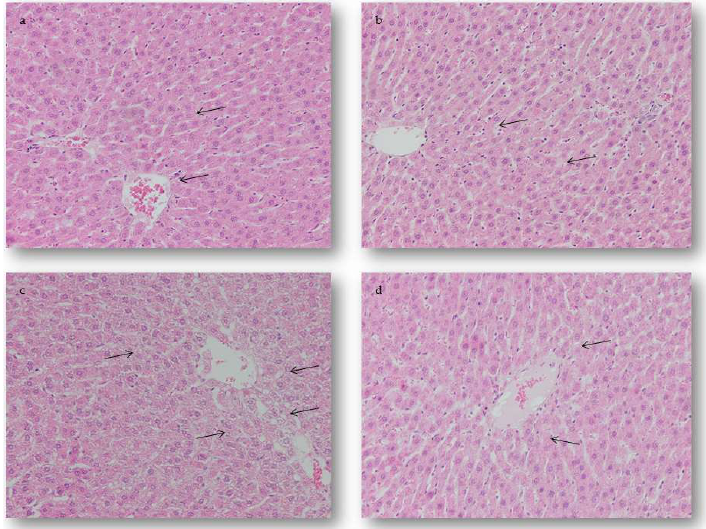
Figure 5. Light micrographs of the hepatic lesions of rats 28 days after receiving last treatment. Hematoxylin and eosin (H&E) stain, magnification 200×. ( a ) Normal histological structure of the hepatic tissue marked with arrow. ( b ) The AMI-treated group, mild oedema in the sinusoidal spaces marked with arrow. ( c ) The DOX-treated group, severe intracellular degeneration marked with arrow. ( d ) The AMI + DOX-treated group, mild intracellular degeneration marked with arrow.